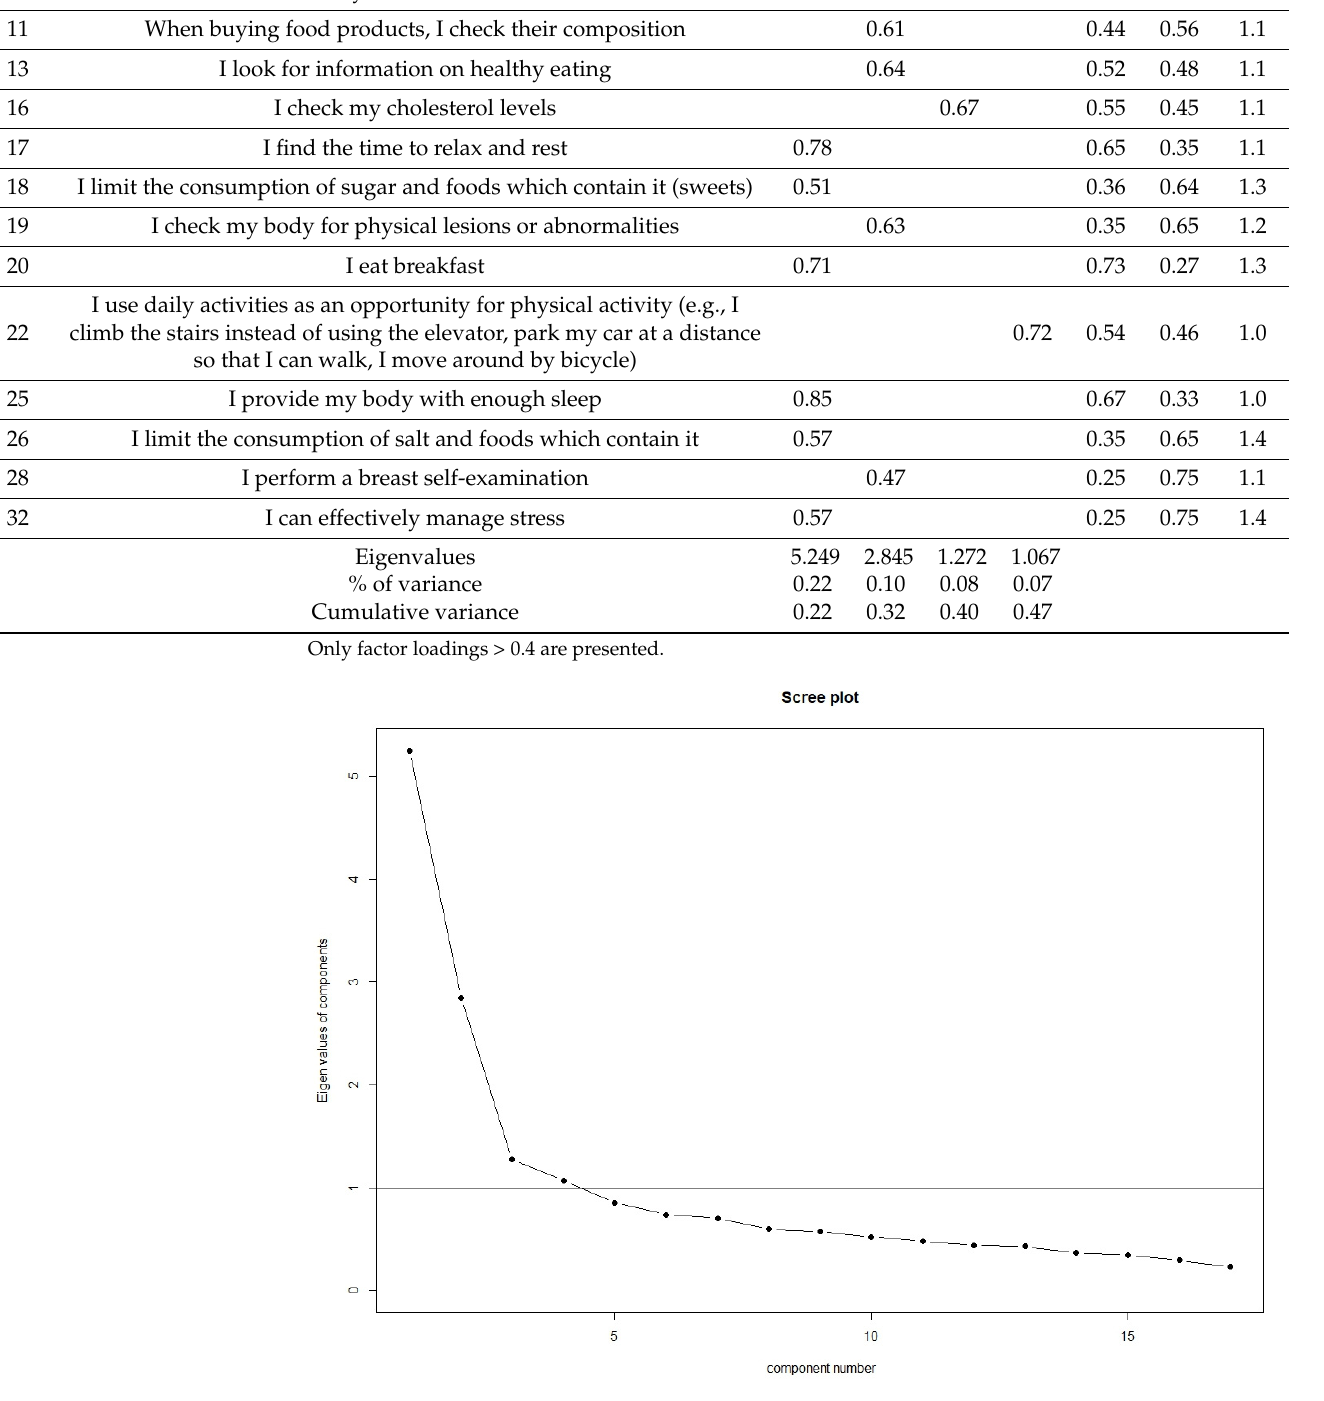
Figure 2. Scree plot of factors. Kaiser criterion is shown by the black horizontal line. Table 1. Factor Loadings and Item Communalities by EFA (n = 487).